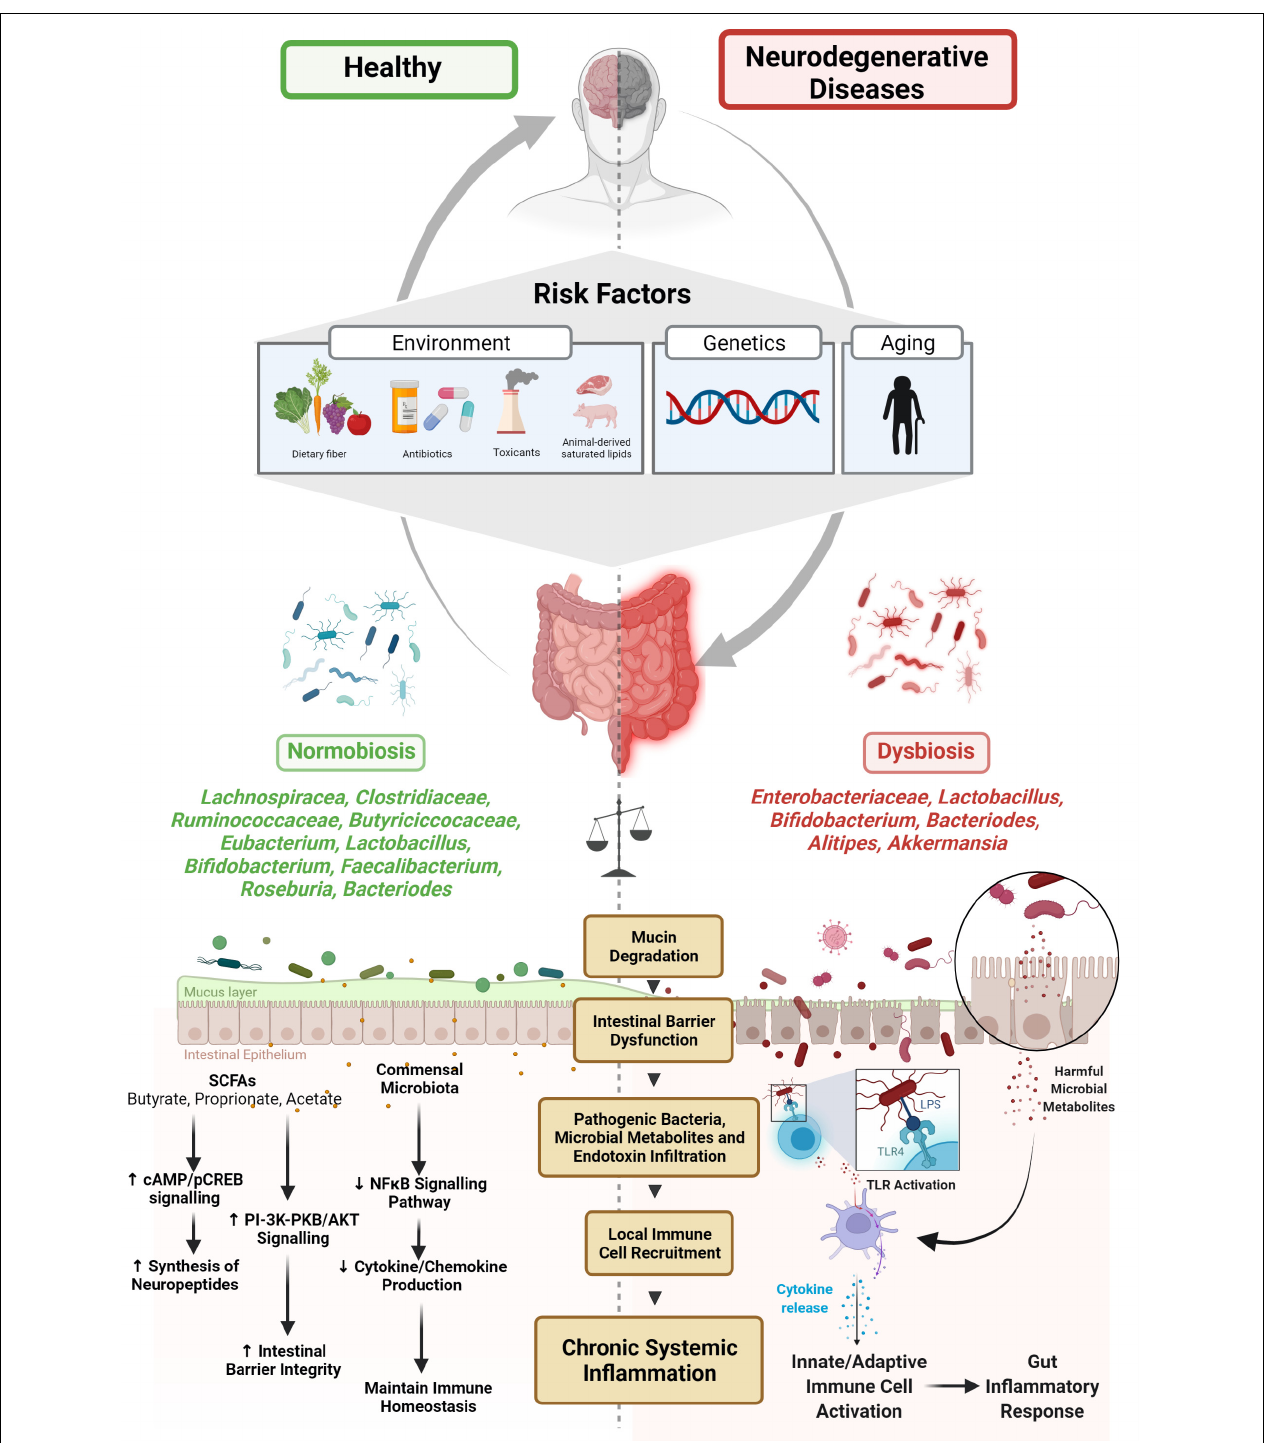
FIGURE 1 | Microbiome-gut-brain axis and neurodegenerative disease. Several risk factors have been associated with the etiology of microbial dysbiosis and neurodegenerative disorders. The balance between normobiosis and dysbiosis within the gut microbiome is preserved by the presence or absence of high-abundant species ( Lachnospiracea, Clostridiaceae, Ruminococcaceae, Eubacterium, Butyriciccocaceae, Lactobacillus, Bifidobacterium, Faecalibacterium, Roseburia , and Bacteroides ) and low-abundant species ( Enterobacteriaceae, Alistipes , and Akkermansia ). In the presence of beneficial microbes, homeostatic mechanisms such as neuropeptide synthesis, promotion of intestinal barrier integrity and immune cell regulatory functions are maintained. Higher abundances of microbes are associated with dysbiosis, degrade mucin, dysregulate intestinal barrier, and enable pathogenic microbes and their metabolites and endotoxins to infiltrate, promoting local immune cell recruitment and triggering systemic